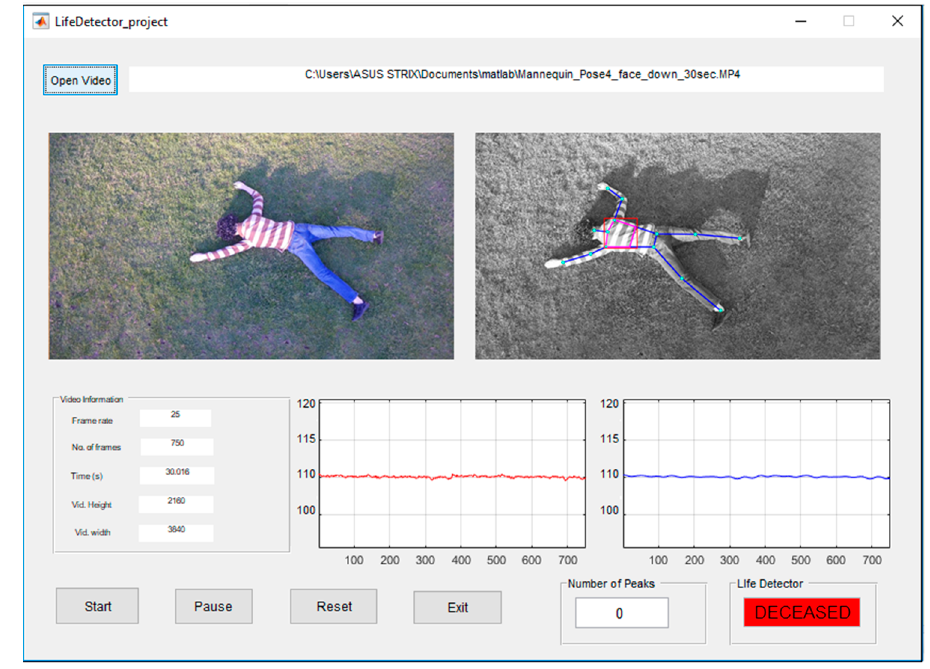
Figure 7. The graphical user interface (GUI) main panel of the proposed life detector system the mannequin (deceased).